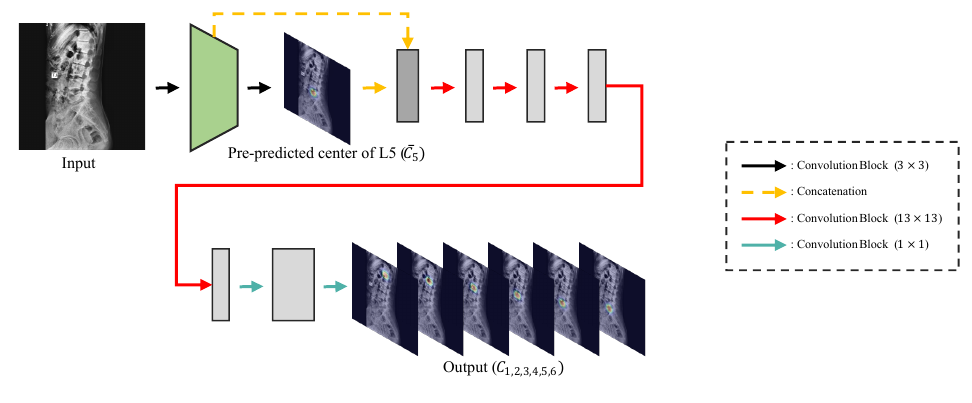
Figure 3. Structure of our Pose-Net.